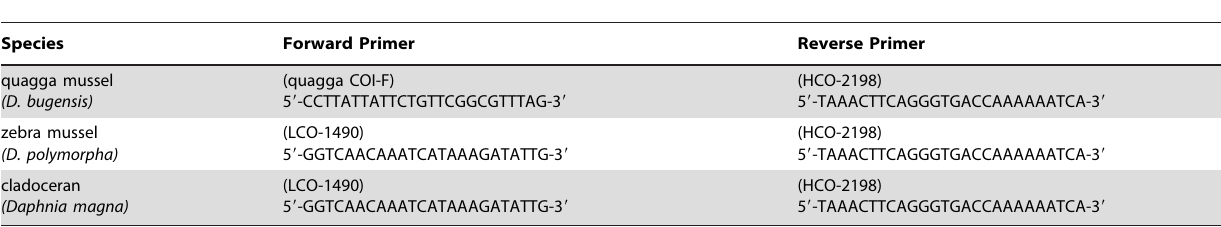
Table 2. Molecular markers (primers) utilized for PCR amplification.